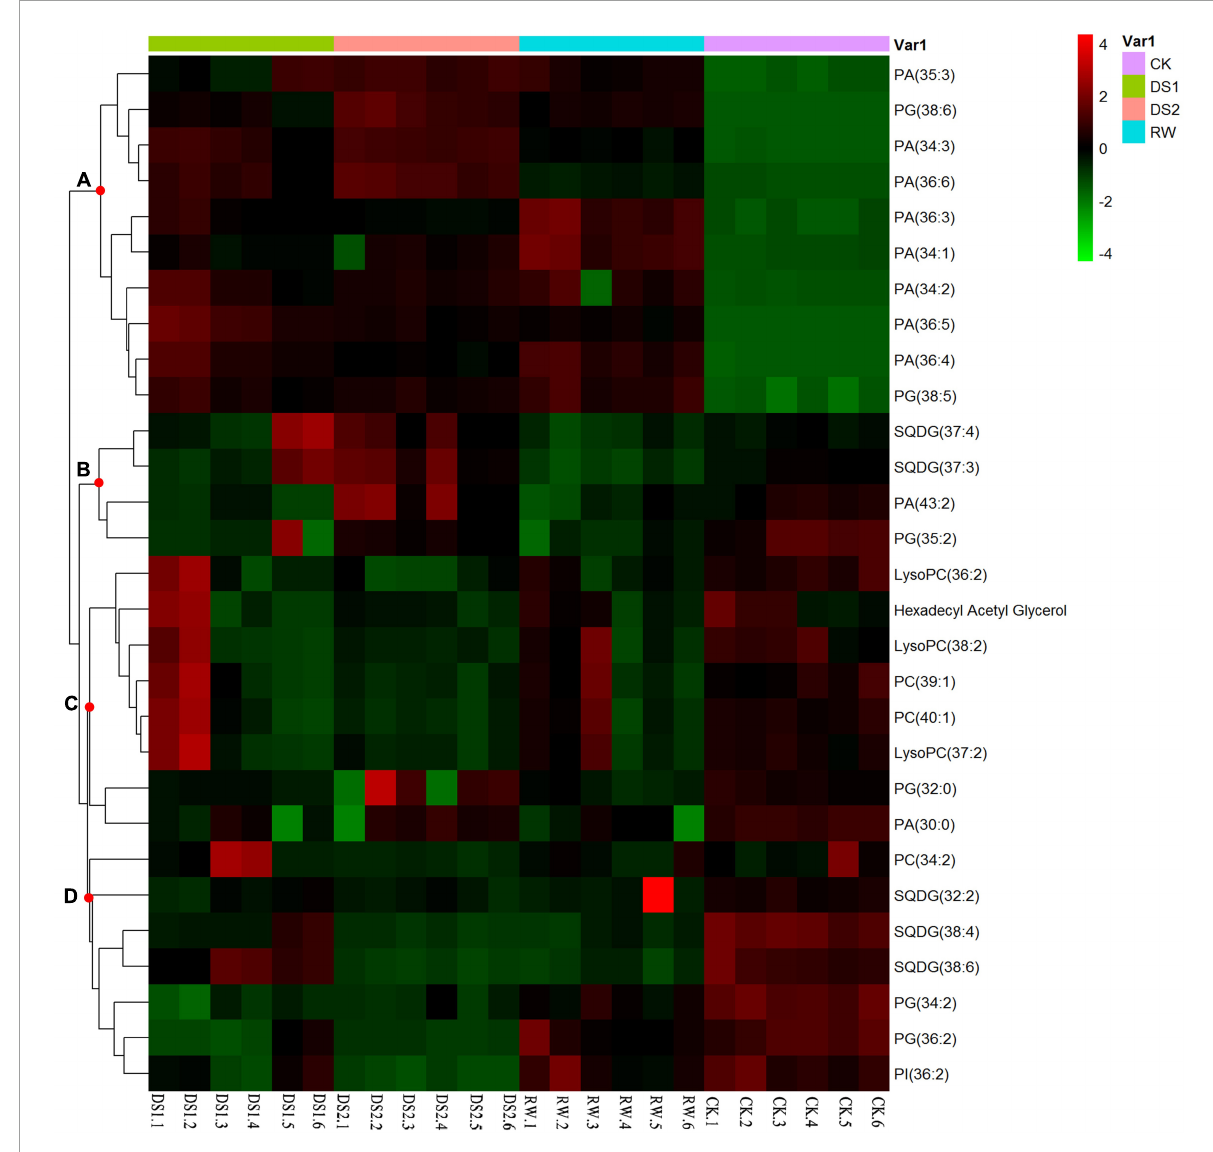
FIGURE5 Hierarchical clustering of 29 lipids from tea leaf samples of four different conditions. Similarity assessment for clustering was based on the Euclidean distance coefficient and the average linkage method. Columns and rows represent individual metabolites and different samples, respectively. The levels of the metabolites changed and could be organized into four clusters, named (A–D)